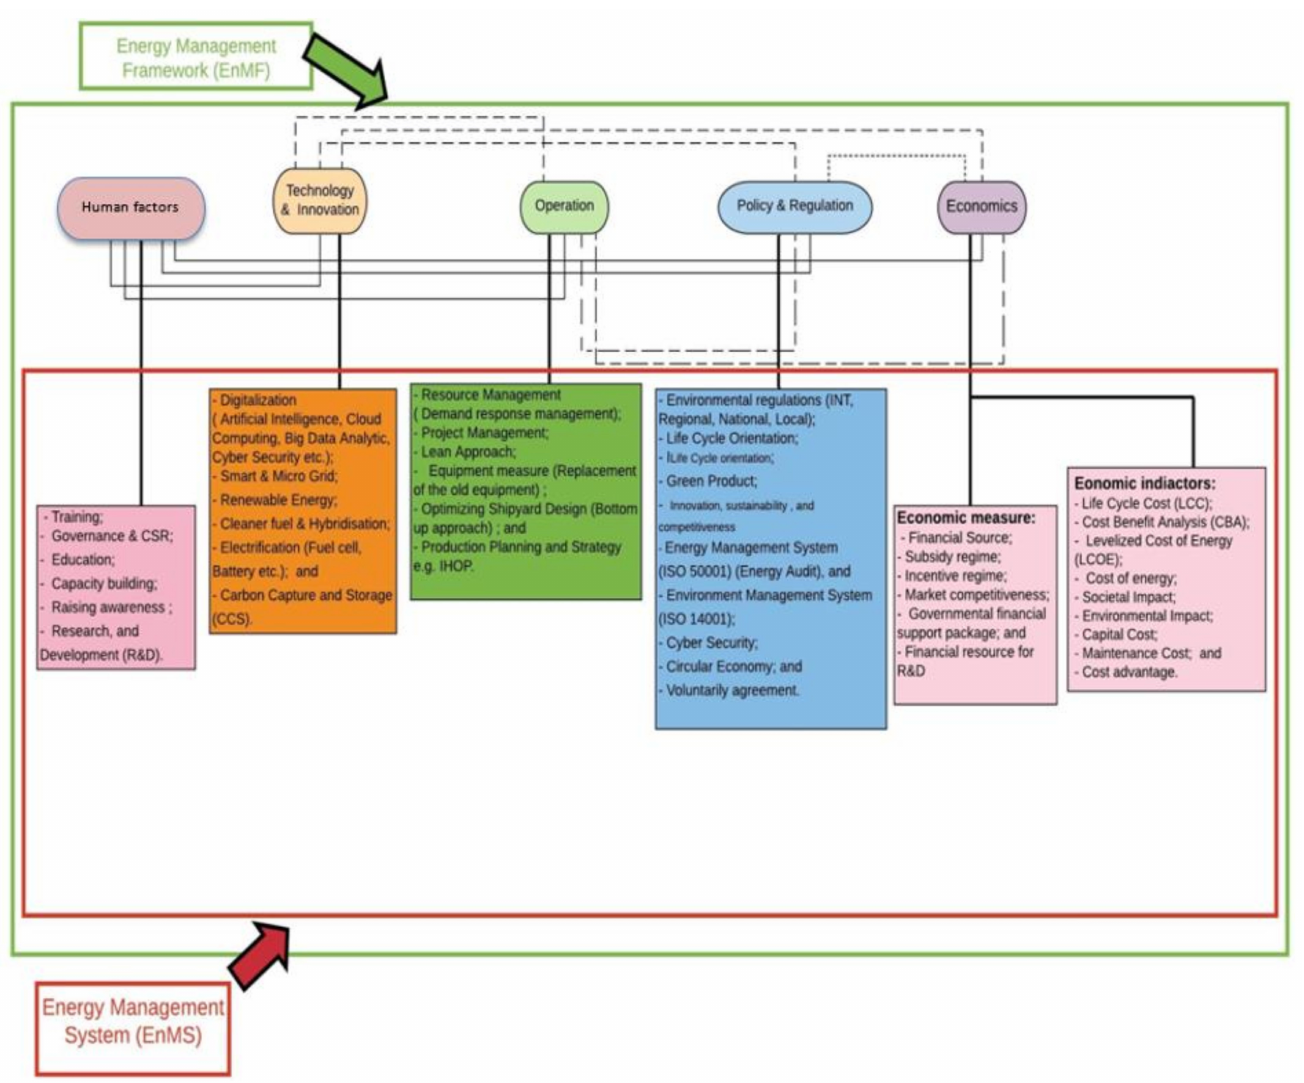
Figure 1. EnMF and EnMS in